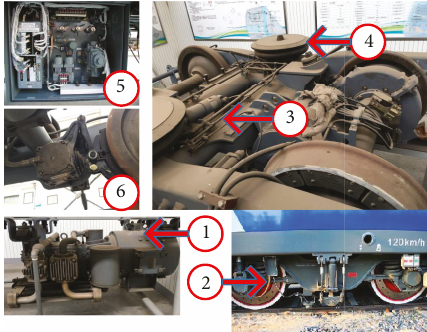
Figure 1: Air braking system structure. 1 — air supply device,